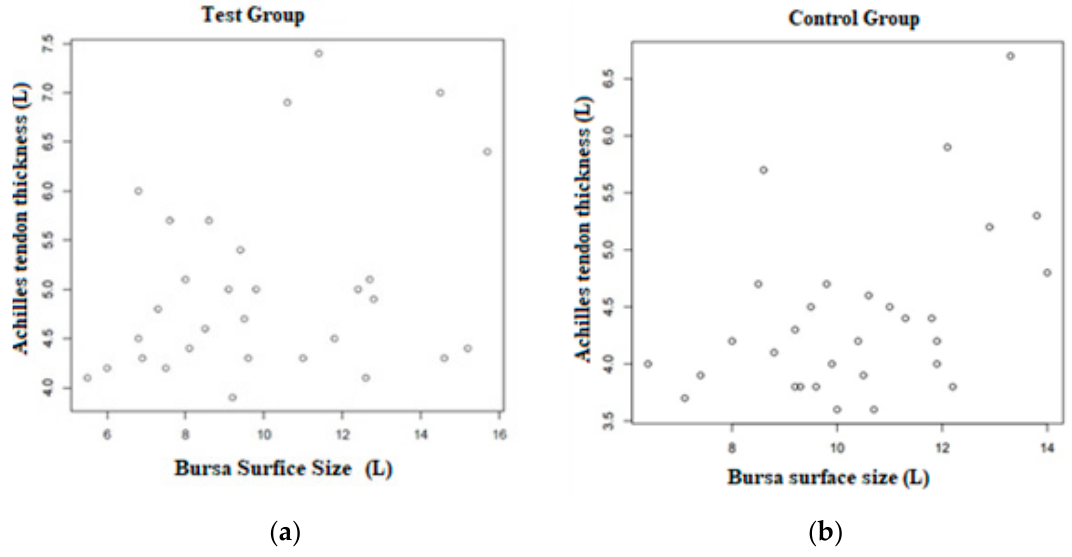
Figure 5. ( a ). A scatter graph presenting the correlation between the Achilles tendon thickness and the surface size of the bursa in the test group ( N = 30). ( b ). A scatter graph presenting the correlation between the Achilles tendon thickness and the surface size of the bursa in the control group ( N = 30).